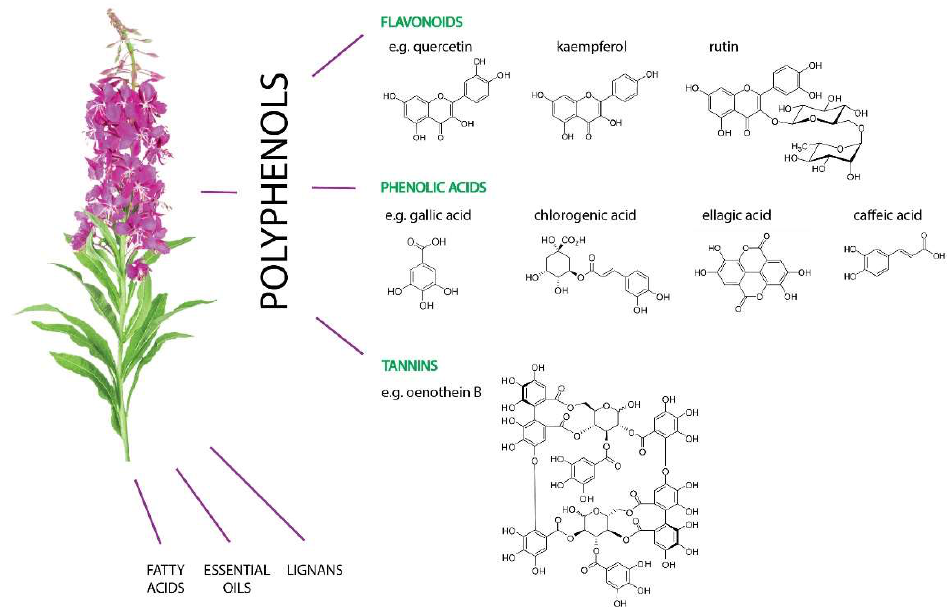
Figure 2. Groups of active compounds contained in E. angustifolium with examples of chemical structures. The main group is polyphenols including flavonoids, phenolic acids, and tannins. E. angustifolium is also a valuable source of fatty acids, essential oils as well as lignans.